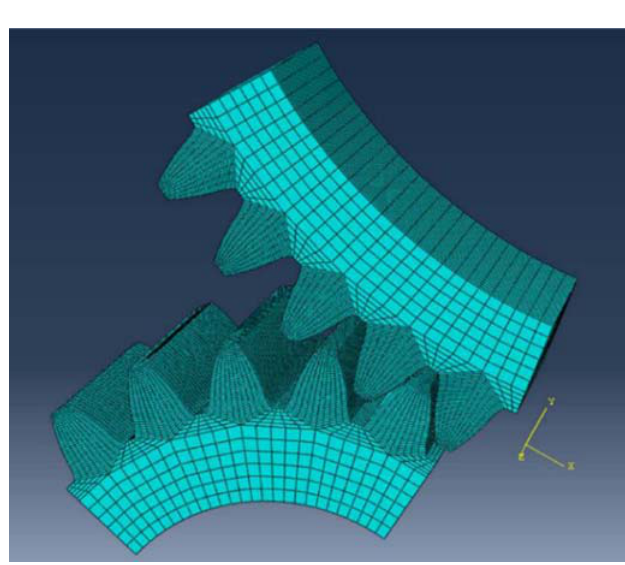
Fig. 7. Quasi-static FEM of CRC gear drive (mesh).